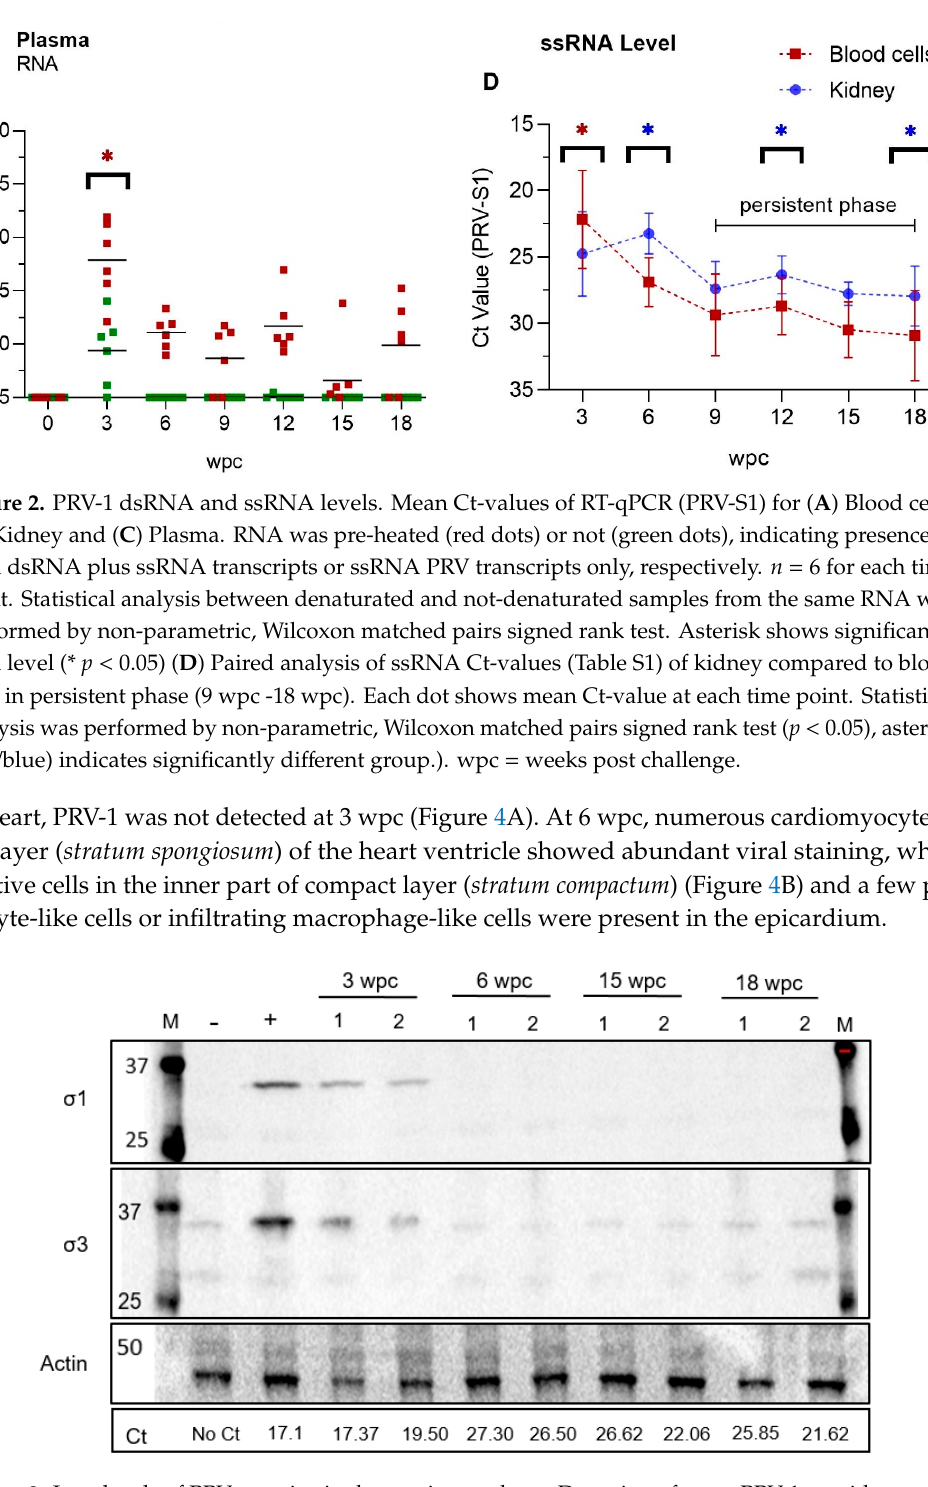
Figure 3. Low levels of PRV proteins in the persistent phase. Detection of outer PRV-1 capsid proteins σ 1 and σ 3 in blood cells from 3–18 weeks post challenge (wpc) by western blotting. Ct values in lower row. Actin (42 kDa) was used as a protein load control. Blood cells from uninfected fish used as negative control. Positive control sample from a fish having Ct value of 17.1 and significant σ 1 protein level [15].